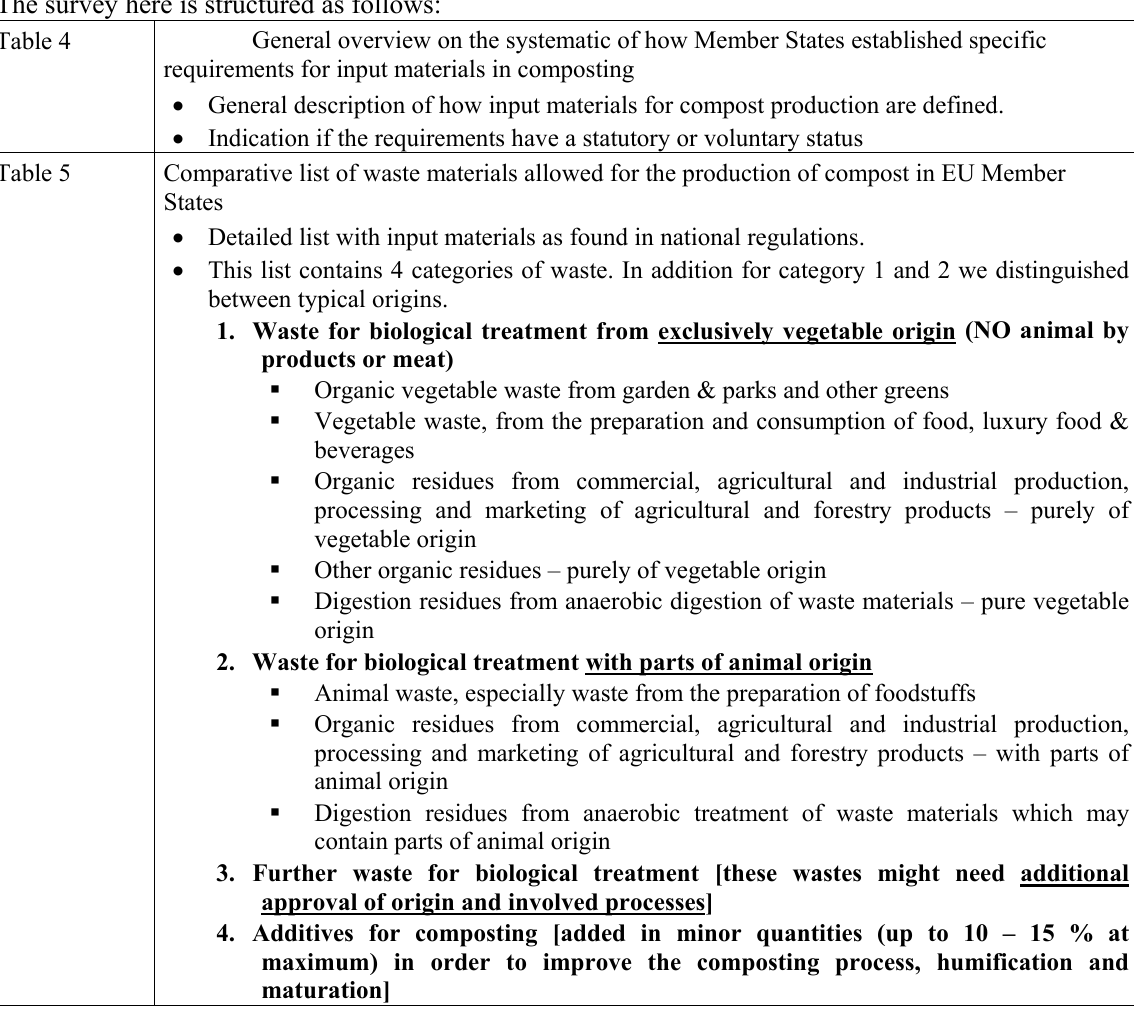
General overview on the systematic of how Member States established specific requirements for input materials in composting